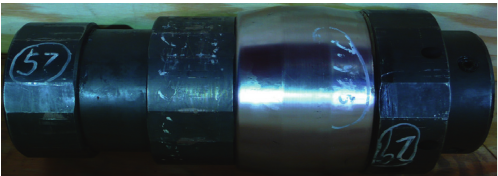
Figure 20: Expansion cone assembly.